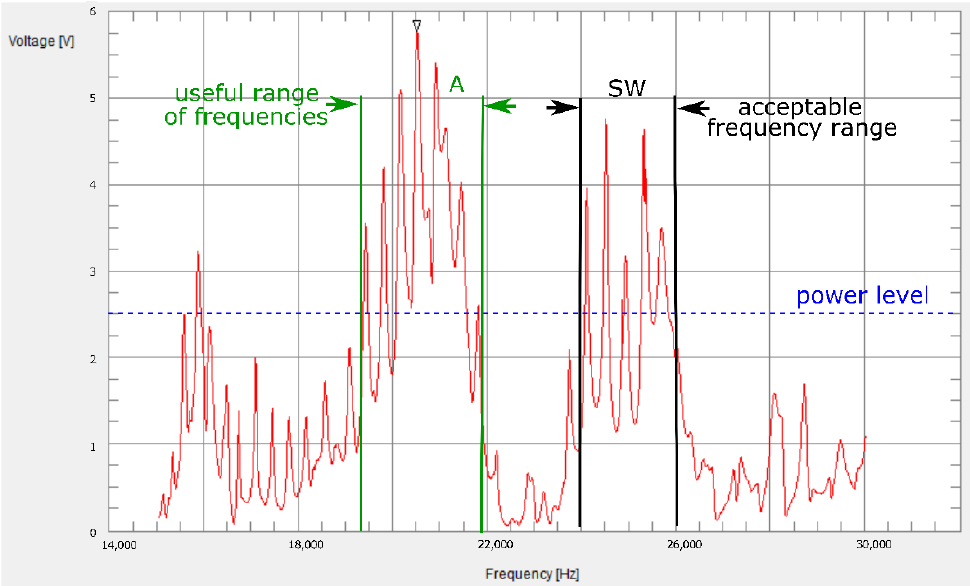
Figure 9. Frequency response of the dual-beam system.